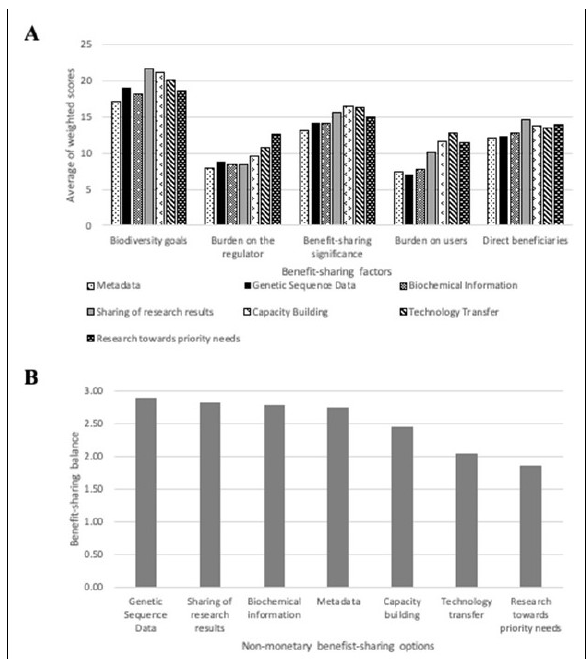
Figure 3. A) Average weighted scores for the seven non- monetary benefit-sharing options according to the five benefit- sharing factors, and B) scores according the benefit-sharing balance equation for the seven non-monetary benefit-sharing